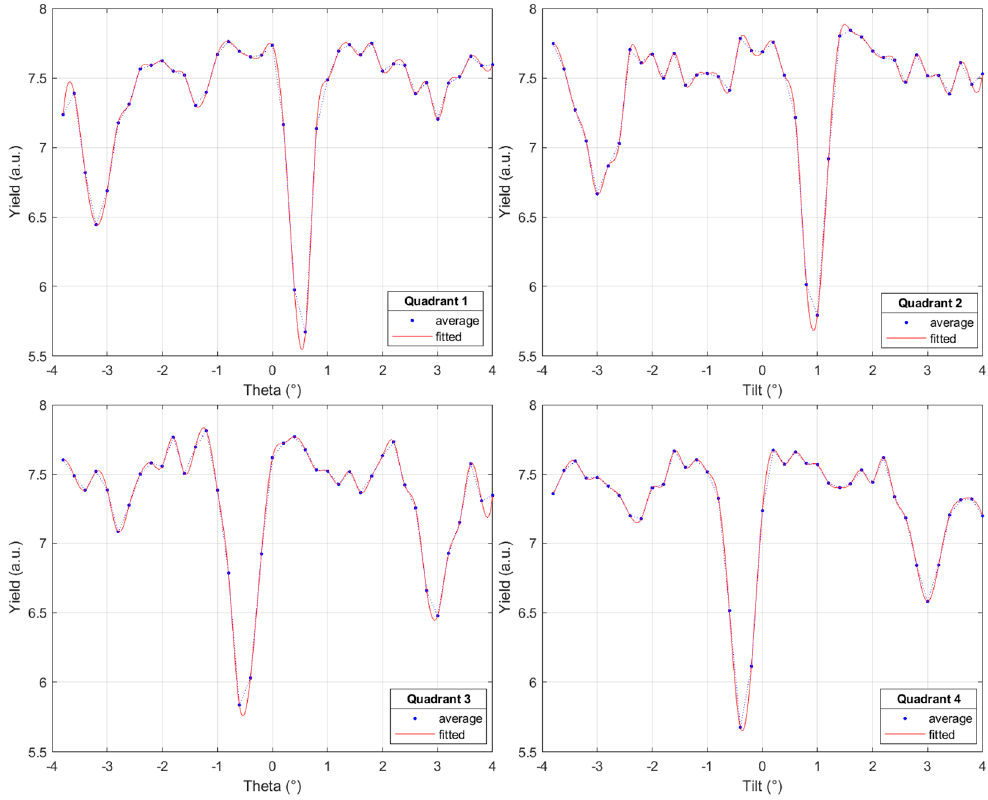
Figure 14. Local minima in each of fourth quadrants with the yield given by the sum over the ROI. Another implemented feature is a 3D rotating view showing all the processed quad- rants data in a complex plot with calculated local minima values (Figure 15). It gives the researcher better possibilities to reorient and analyze the fitted values or to set a ROI. The 3D plot may show local minima values to help determine